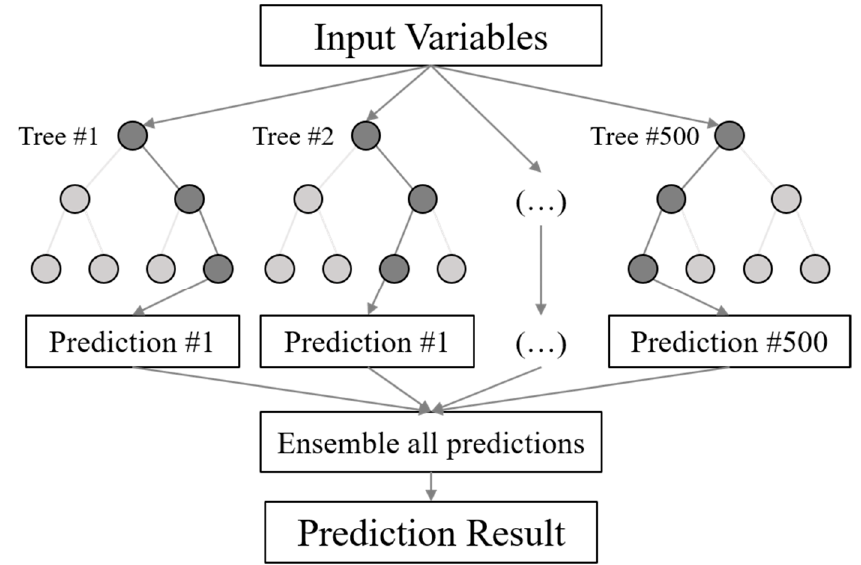
Figure 2. Schematic diagram of the prediction algorithm of the random forest (RF) model.